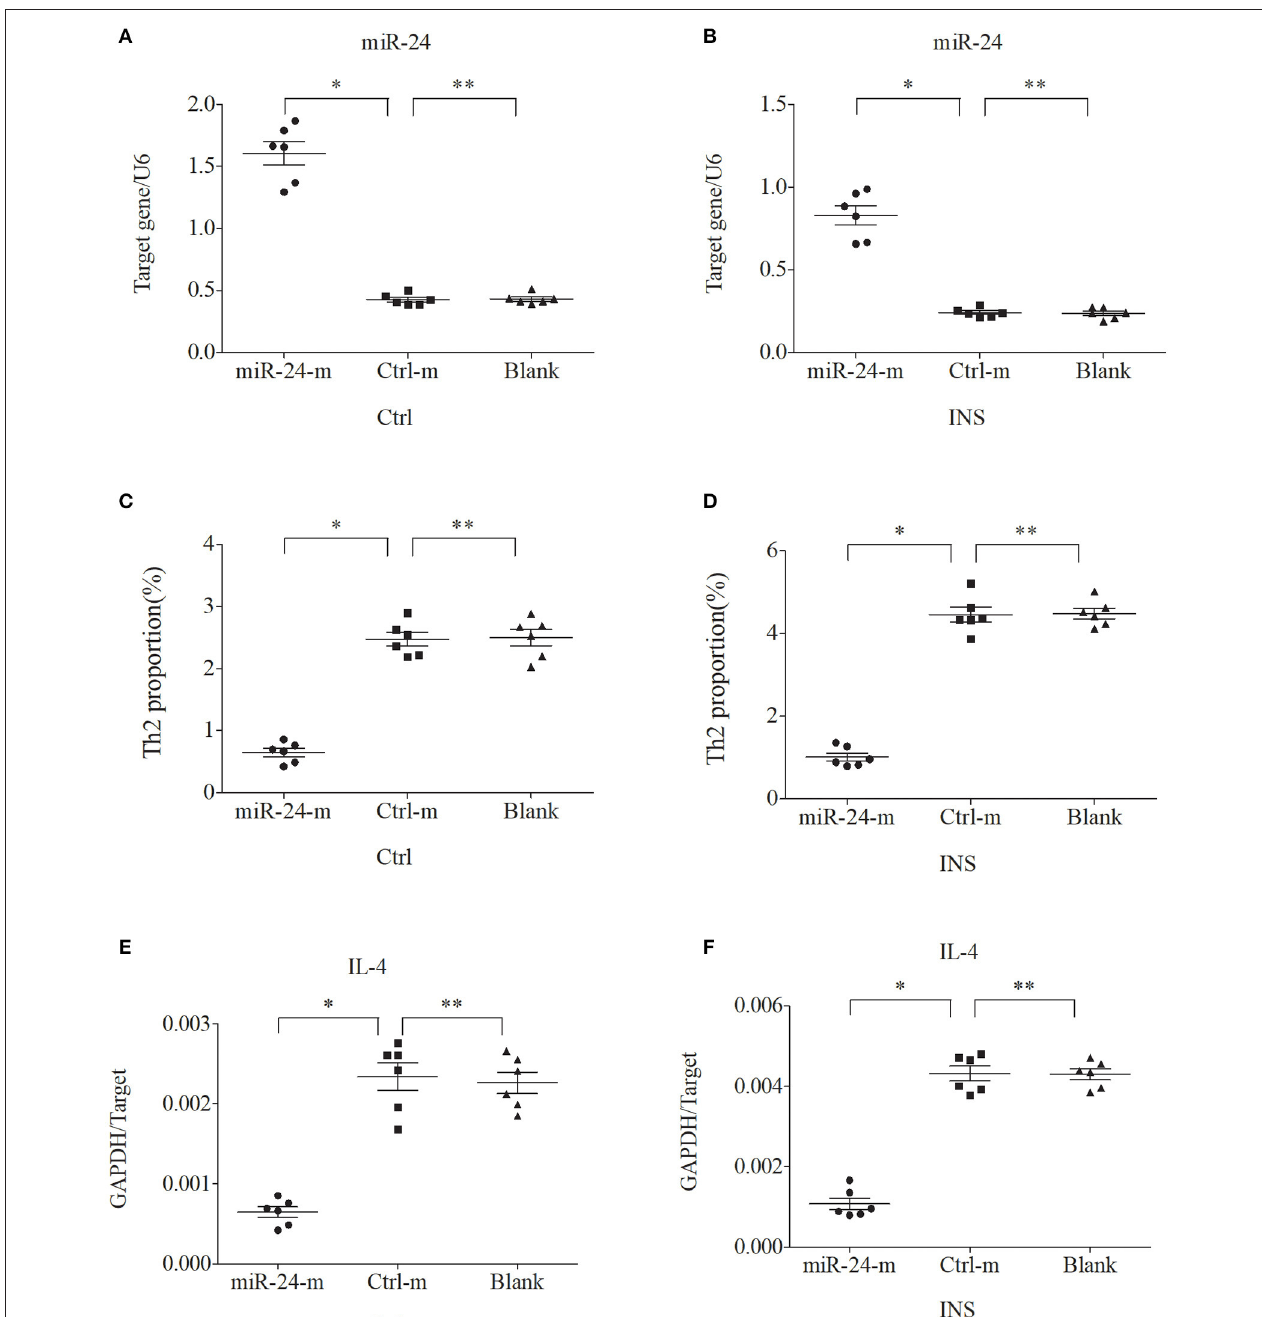
FIGURE 4 | Up-regulation of miR-24 in PBMCs from controls and INS patients (A,B) reduces the percentage of Th2 cells (C,D) and the expression of IL-4 mRNA (E,F) . Here and in Figures 5 – 7 : expression of miRNAs (relative to U6) and IL-4 (relative to GAPDH) were determined by real-time PCR; ANA ( n = 6), Crtl ( n = 6); and abbreviations are Ctrl-m (miRNA negative control), miR-24-m/miR-27-m (miR-24/miR-27 mimic), Ctrl-i (miRNA inhibitor [negative control]), and miR-24-i/miR-27-i (miR-24/miR-27 inhibitor). * P < 0.05 and ** P >